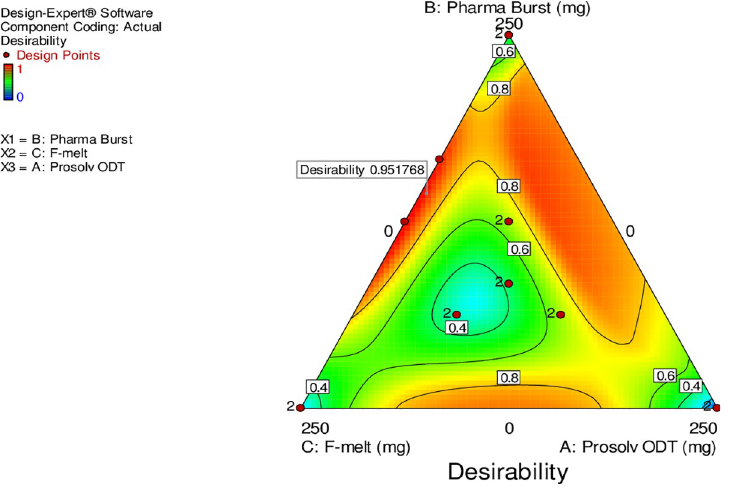
Fig 4. Overlay plot for the effect of formulation variables on the measured responses.